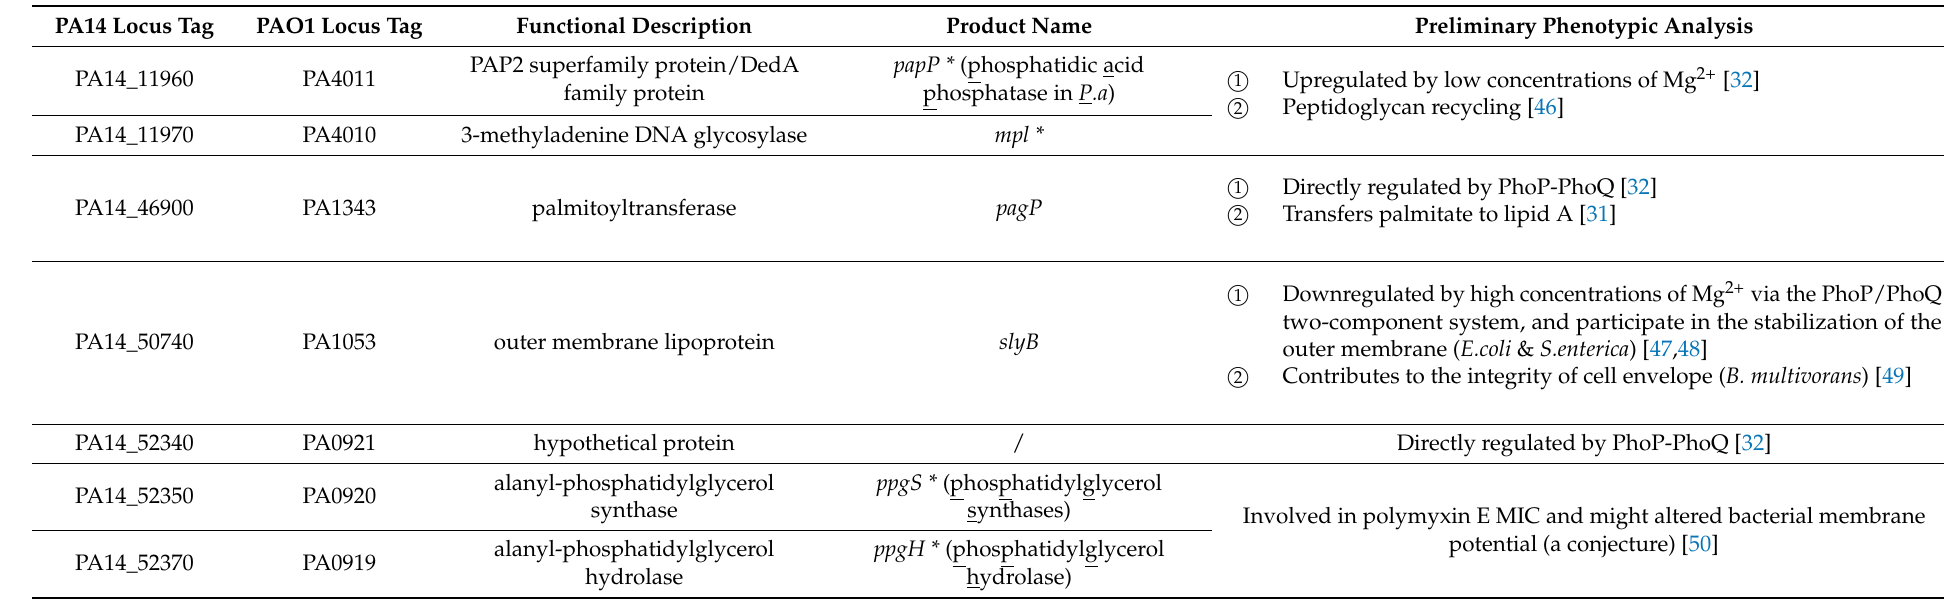
Table 2. Functions of the identified PhoP regulated